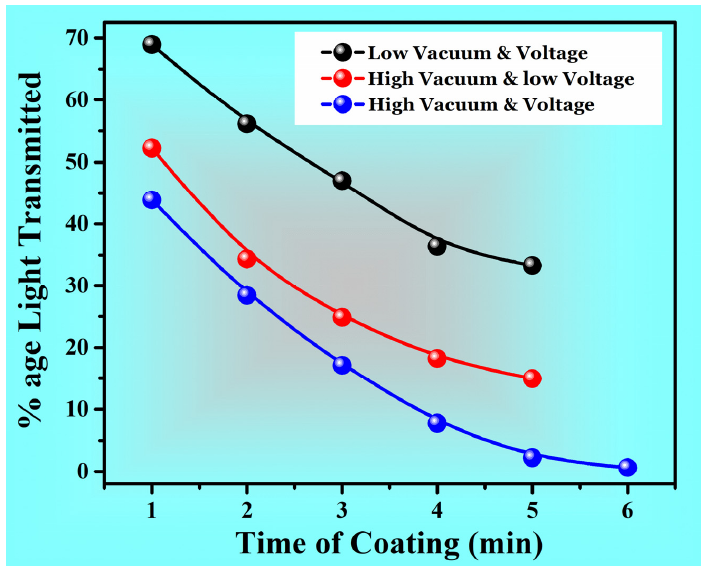
Figure 6. Comparison of Sputtered Coatings under Different Conditions.